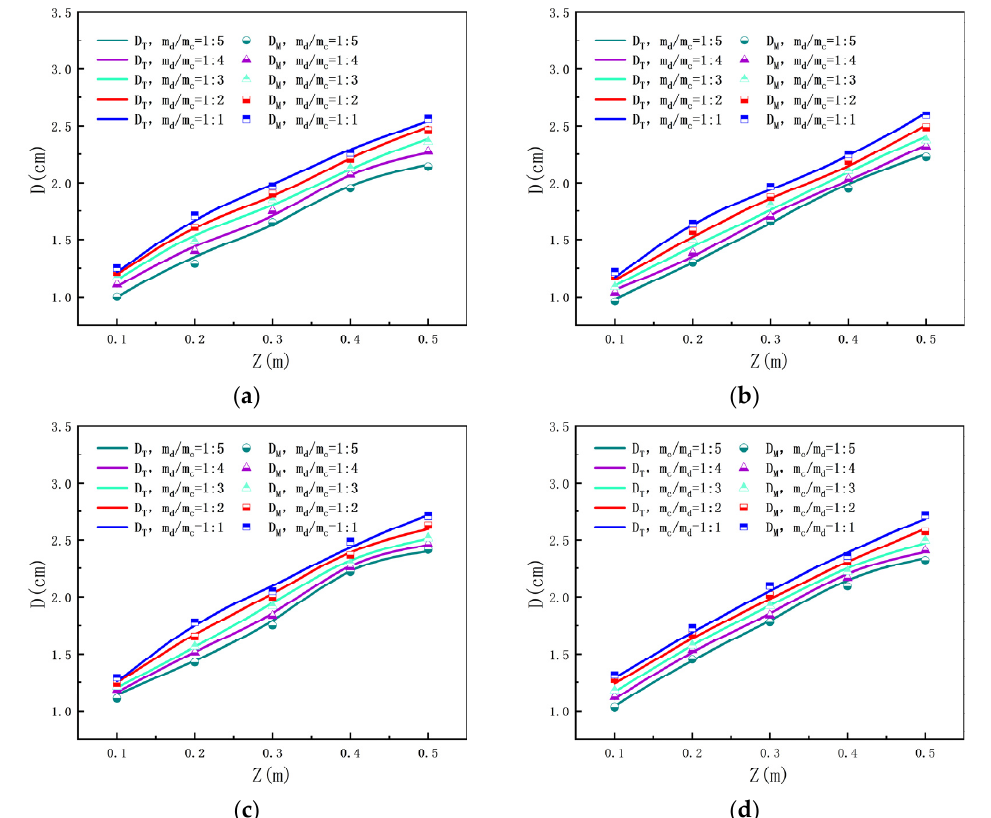
Figure 3. The relationship between bubble diameter and height (Z) at different temperatures. ( a ): T c = 50 °C. ( b ): T c = 60 °C. ( c ): T c = 70 °C. ( d ): T c = 80 °C.